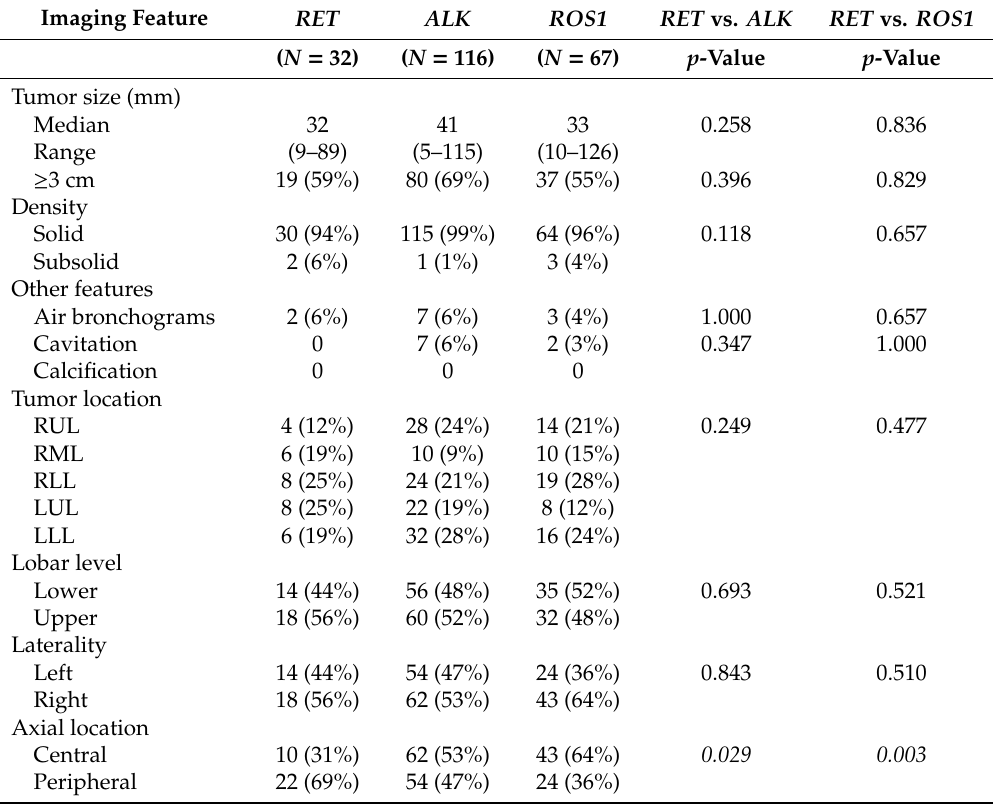
Imaging features of the primary tumor in patients with RET , ALK , or ROS1 fusion-positive